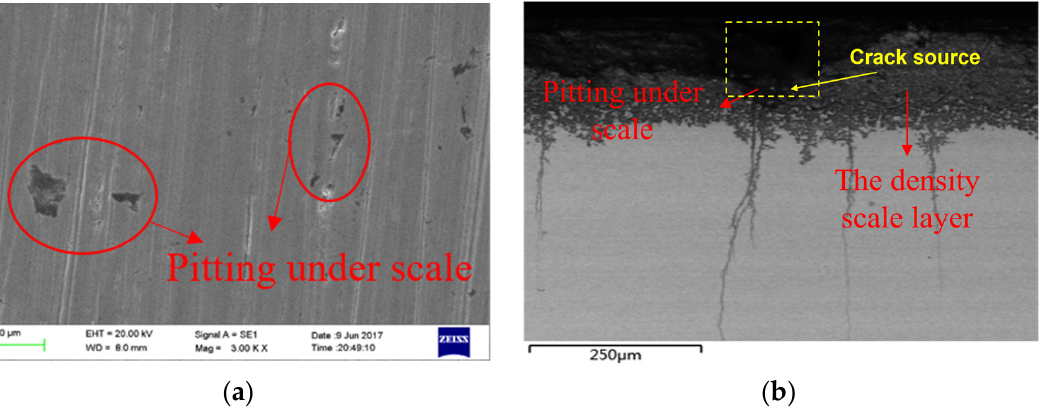
Figure 7. Micromorphology of Corrosion under Scale of Tubing (SEM). ( a ) Micromorphology of Corrosion Pits on Oil Pipe Surface. ( b ) Corrosion Microtopography of Tubing Section.